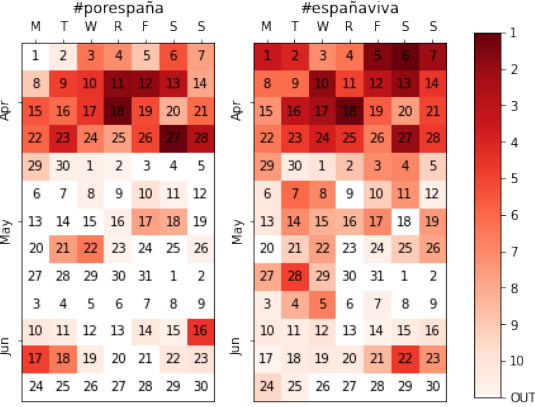
Figure 8. Side-by-side comparison between Vox’ official slogan (#porespaña) and the most used hashtag on social media during the campaign